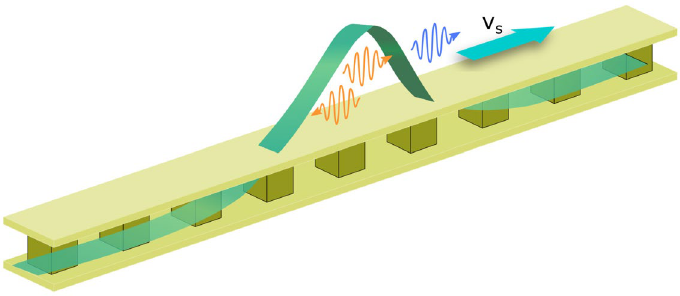
Figure 3. Schematic sketch of the black hole laser in the circuit. The refractive index perturbation δ n (η) (green) moving with the velocity v s changes the velocity of the probe pulses (orange wave packets) and classically traps them inside the soliton acting as the cavity. The probe pulses can be radiated quantum-mechanically as Hawking radiation (blue) by pair productions near the horizon.